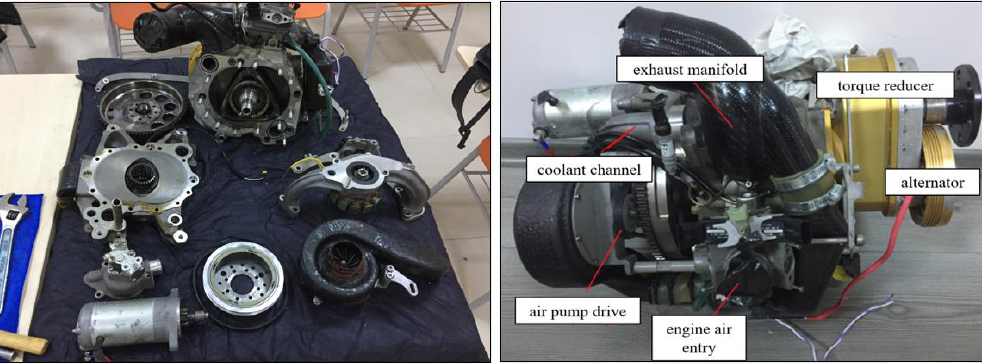
Figure 1. Demonstration of the components of the Wankel test engine and definition of some of its parts.